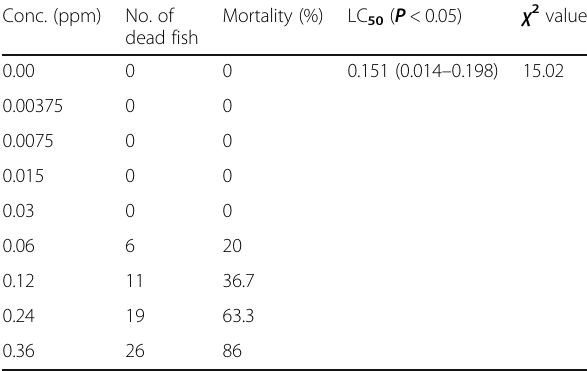
Table 2 LC 50 of Heteropneustes